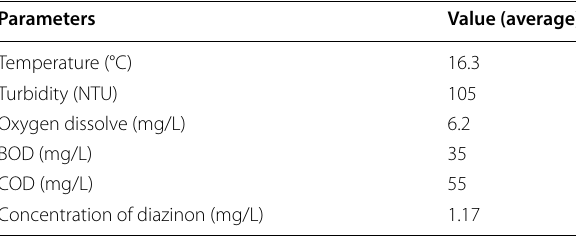
Table 9 Characteristics of raw water of Seymareh Rive